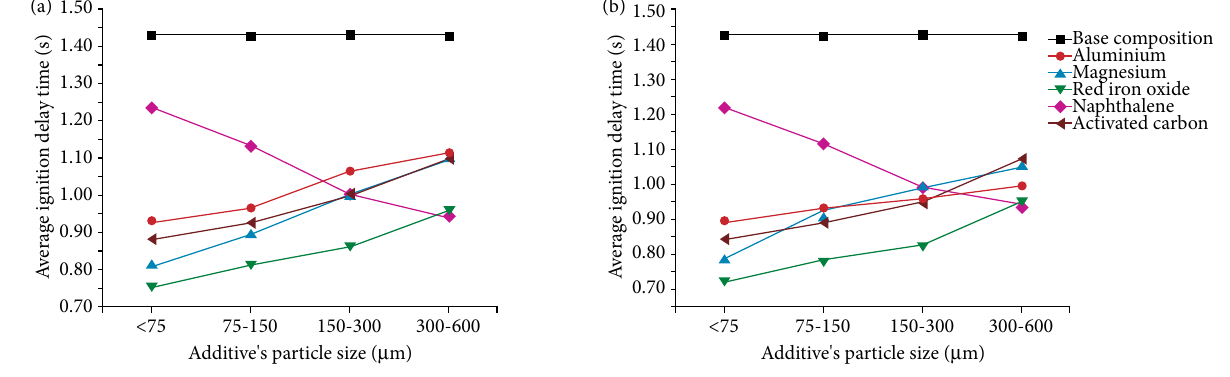
Figure 3. Average ignition delay times with additive’s wt.% as; (a) 3%, and (b)